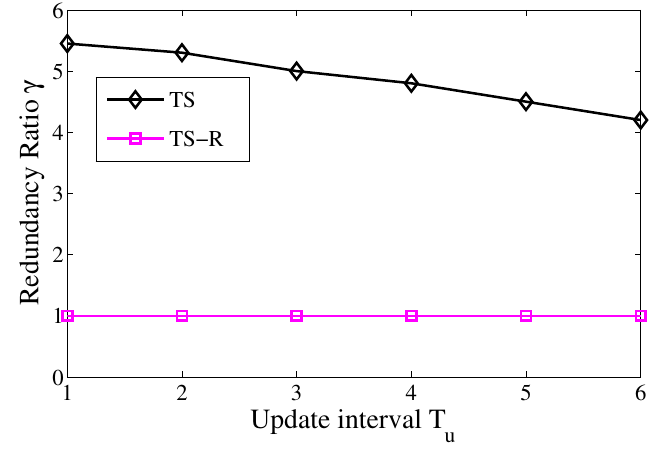
Figure 11. Redundancy ratio of